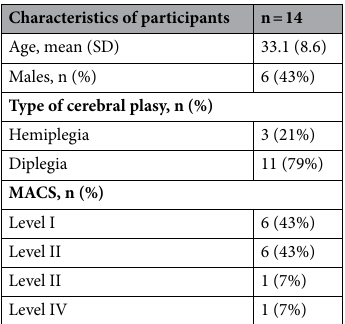
Table 1. Characteristics of participants with cerebral plasy. MACS Manual Ability Classification System.